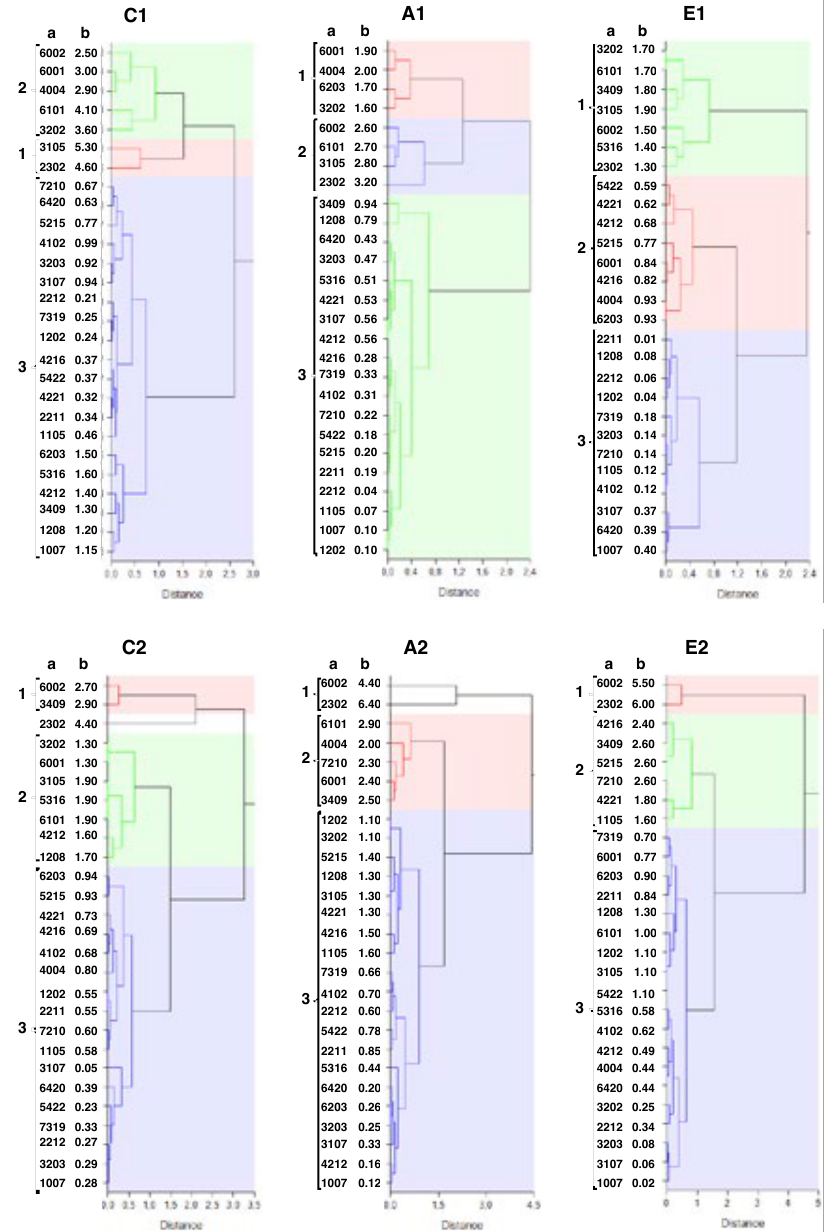
Figure 3. Hierarchical tree clustering based on relative expression values of the 27 differentially expressed protein spots identified in the groups of asymptomatic (C1, A1, E1) and black streaked wood (C2, A2, E2) from control (C1, C2), apoplec - tic (A1, A2) and esca proper affected grapevines (E1, E2). The relative value of optical density × area (relative OD × area %) of the total value observed in the gel images was considered as a measure of expression. Relative mean values are from three relative values obtained by dividing the value of each spot to the total density of the corresponding gel. Hierarchi - cal tree clustering was performed using the NCSS 8 software by NCSS Statistical Analysis & Graphics (http://www.ncss. com/). Clustering parameters were set up as follows: group average (unweighted pair-group) linkage type, Euclidean dis - tance method, average absolute deviation scaling method, cluster cutoff at 1.0. Numbers in parentheses indicate clusters from greatest values (cluster 1) to the smallest (cluster 3). Column a: spot number; column b: relative expression